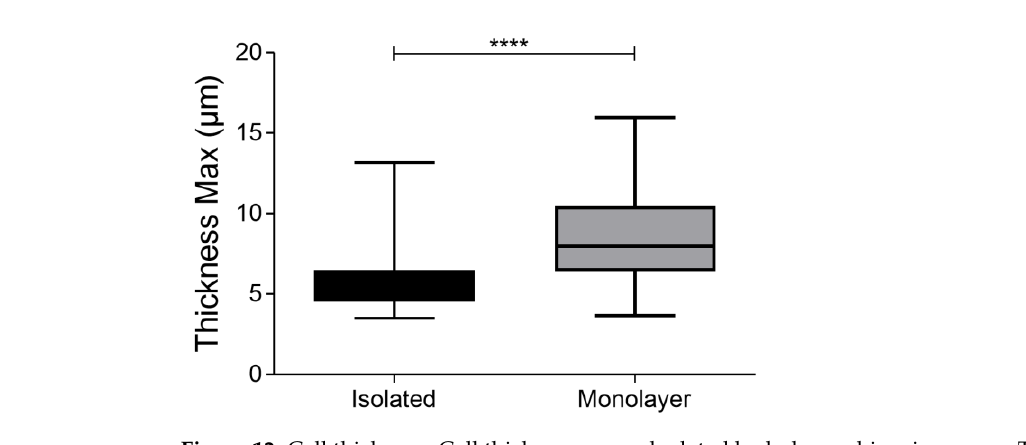
Figure 12. Cell thickness . Cell thickness was calculated by holographic microscopy. The histogram represents the medium value of the thickness of 100 cells compared to 40 islands/monolayers of cells. The statistical analysis is on a non-parametric Kolmogorov – Smirnov test. (**** p < 0.001).